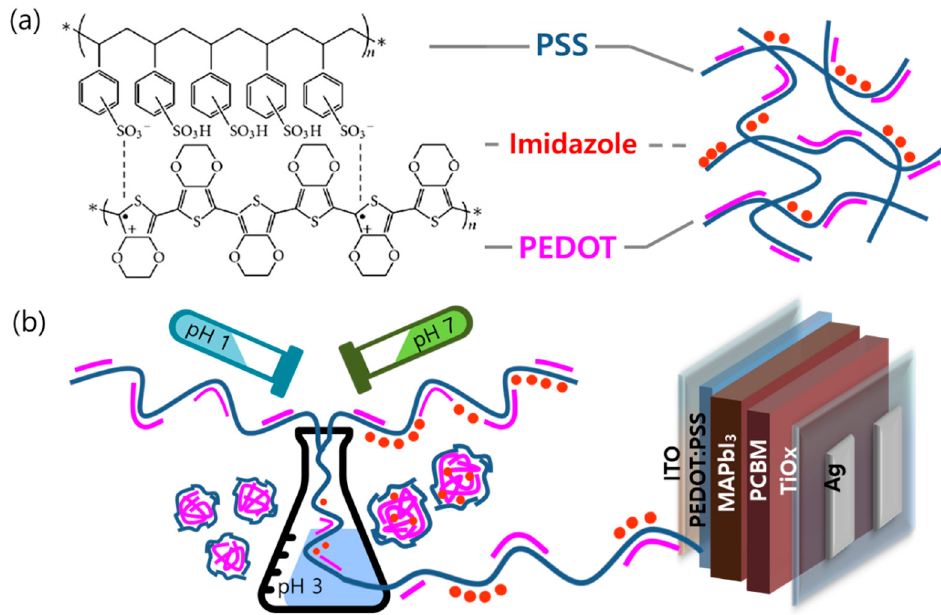
Figure 1. ( a ) Structure and schematic representation of PEDOT:PSS. ( b ) The solution fabrication process and polymer composite structure of pH-controlled PEDOT:PSS for inverted